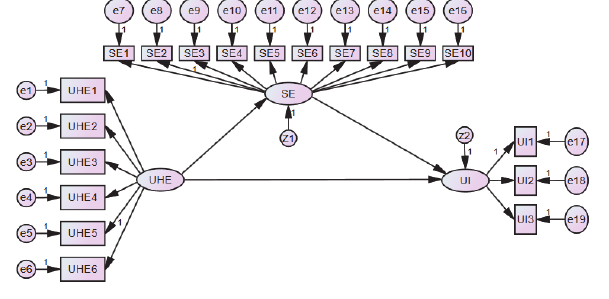
Fig. 1. Full Structural Model Analysis